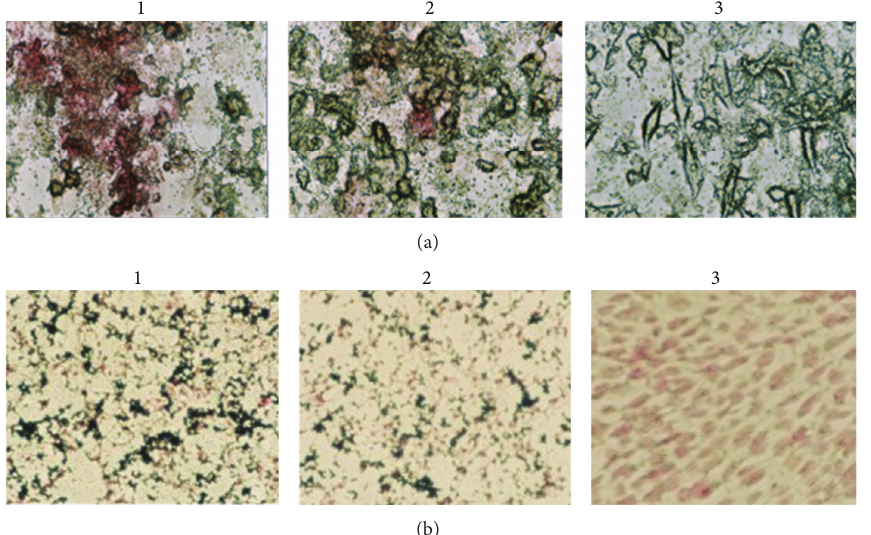
Figure 4: Histochemical analysis. C3H10T1/2 cells were plated into 40mm culture dishes and cultivated for 2 days. Cells were then treated with 250 ng/mL recombinant mature BMP-2 or 1 𝜇 g/mL synthetic polypeptide of the knuckle epitope of human BMP-2 for 6 days culture before staining. (a) Alkaline phosphatase staining at 6 days. (b) von Kossa staining at 6 days. 1: recombinant Pf BMP-2; 2: the synthetic polypeptide of the knuckle epitope of human BMP-2; and 3: control culture. Cells were photographed at 100x magnification.